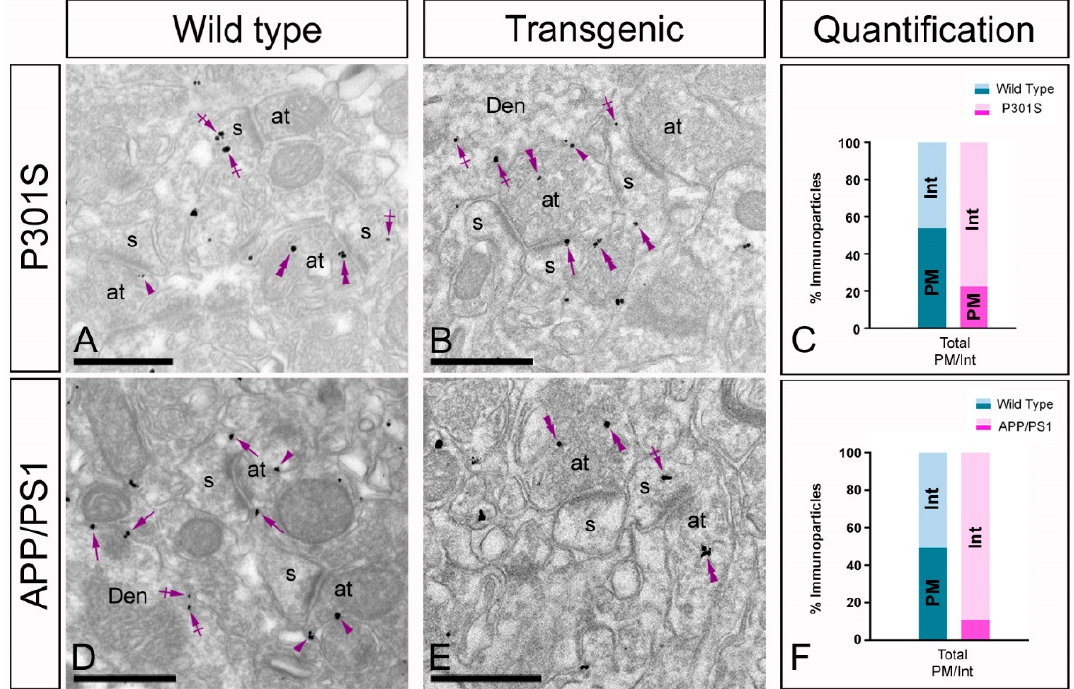
Figure 6. Changes in the presynaptic localisation of GIRK2 in the hippocampus of P301S and APP/PS1 mice. Electron micrographs illustrating presynaptic immunoparticles for GIRK2 in the stratum radiatum of the CA1 region in 10 months old in wild type and P301S mice at and 12 months old in wild type and APP/PS1 mice, as detected using a pre-embedding immunogold technique. ( A – F ) In wild type mice (panels A , D ), immunoparticles for GIRK2 were found at presynaptic sites, where they localised at the extrasynaptic plasma membrane (arrows) of axon terminals (at) establishing asymmetrical synapses with spines (s), and at intracellular sites (crossed arrows). Both in P301S and APP/PS1 mice (panels B , E ), immunoparticles for GIRK2 found at presynaptic sites in axon terminals were more frequently detected at intracellular sites. Arrows and crossed arrows indicate to GIRK2 immunoparticles in dendritic spines (s) and shafts (Den) at extrasynaptic and intracellular sites, respectively. Scale bars: ( A , B , D , E ): 500 nm.